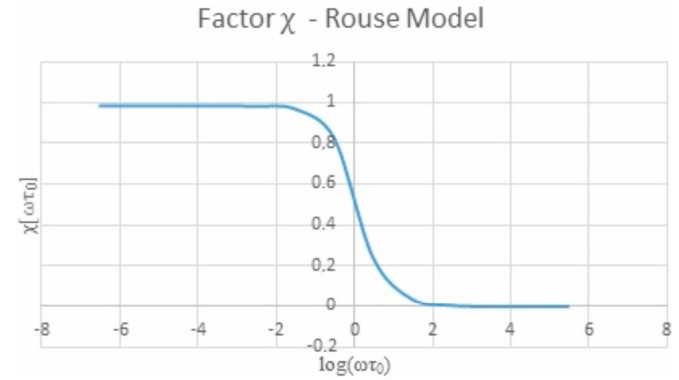
Figure 3. Factor χ for polymeric fluids (pseudoplastic behavior).